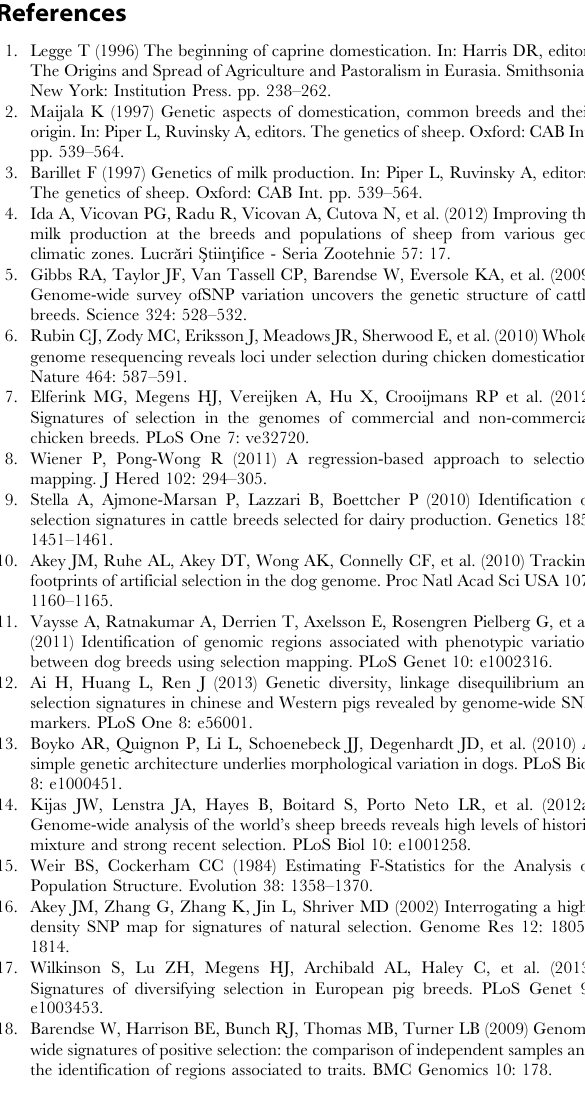
Table S1 Candidate regions for signatures of selection identified on the basis of the pair-wise F ST analysis. Table S2 Candidate regions identified based on reduced heterozygosity signals identified in at least two of the dairy breeds. Table S3 List of all genes from the orthologous bovine genome regions corresponding to the six convergence candidate regions (CCR) for dairy selection sweeps identified in this study, extracted using the Biomart tool (http://www.biomart.org/). Table S4 Candidate regions identified by the analysis based on observed heterozygosity (ObsHtz-CR), averaged in sliding win- dows of 9 SNPs (ObsHtz-9SNPW), that were exclusively detected in dairy